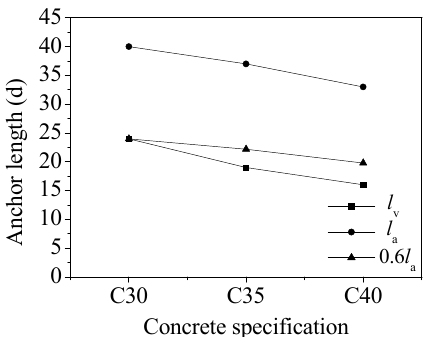
Figure 16. Anchor length curves.